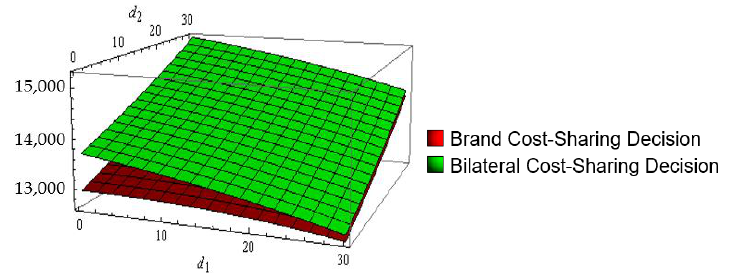
Figure 3. Im pact of Time Delay on the Brand Owner’s Profit. Figure 3. Impact of Time Delay on the Brand Owner’s Profit.